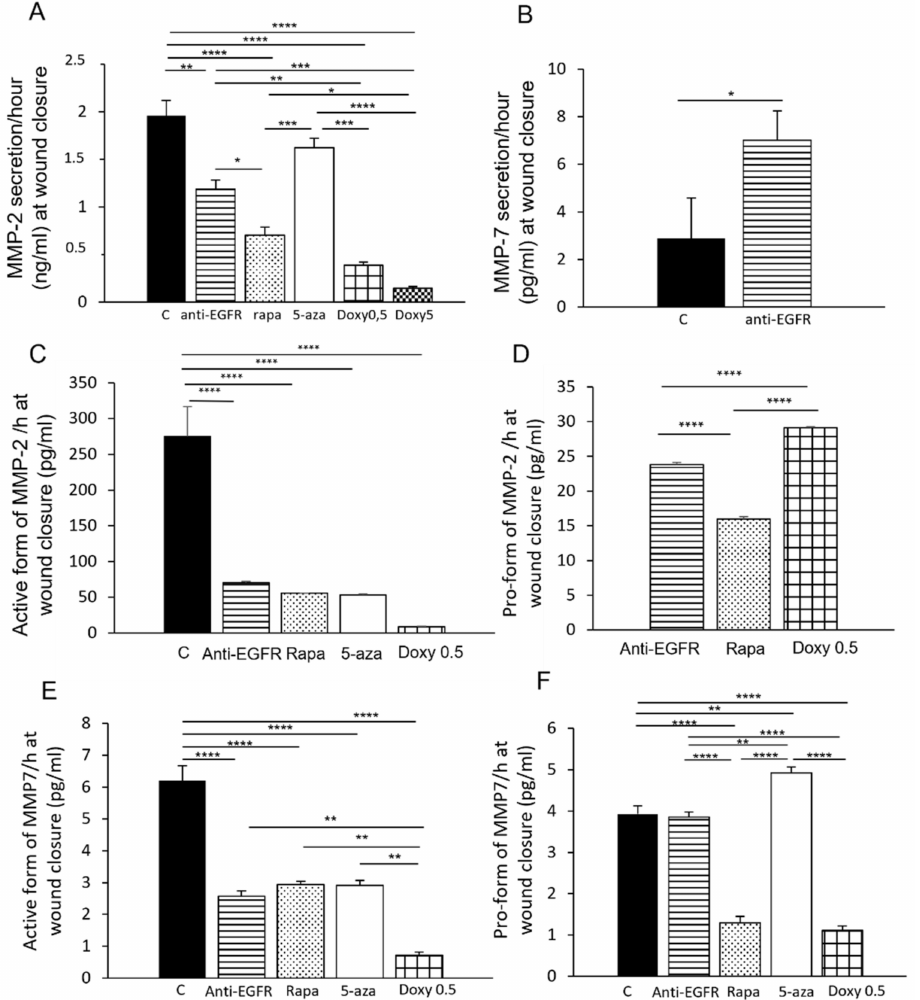
Figure 5. Effect of drug treatment on MMP2 and MMP-7 secretion during wound healing. MMP-2 ( A ) and MMP-7 ( B ) levels were analyzed by ELISA assay at wound closure in all experi- mental groups, as in Figure 4, and expressed as secretion/hour (ng/mL). The presence of the active form ( C ) or the pro-form ( D ) of MMP-2 in the culture medium of all the experimental groups, as in Figure 4, was evaluated by QuickZyme assay and expressed as secretion/hour (pg/mL). The presence of the active form ( E ) or the pro-form ( F ) of MMP-7 in the culture medium of all the experi- mental groups, as in Figure 4, was evaluated by QuickZyme assay and expressed as secretion/hour (pg/mL). ANOVA with Tukey test ± SEM ( n = 3 experiments) * p < 0.05; ** p < 0.01; *** p < 0.001; **** p <